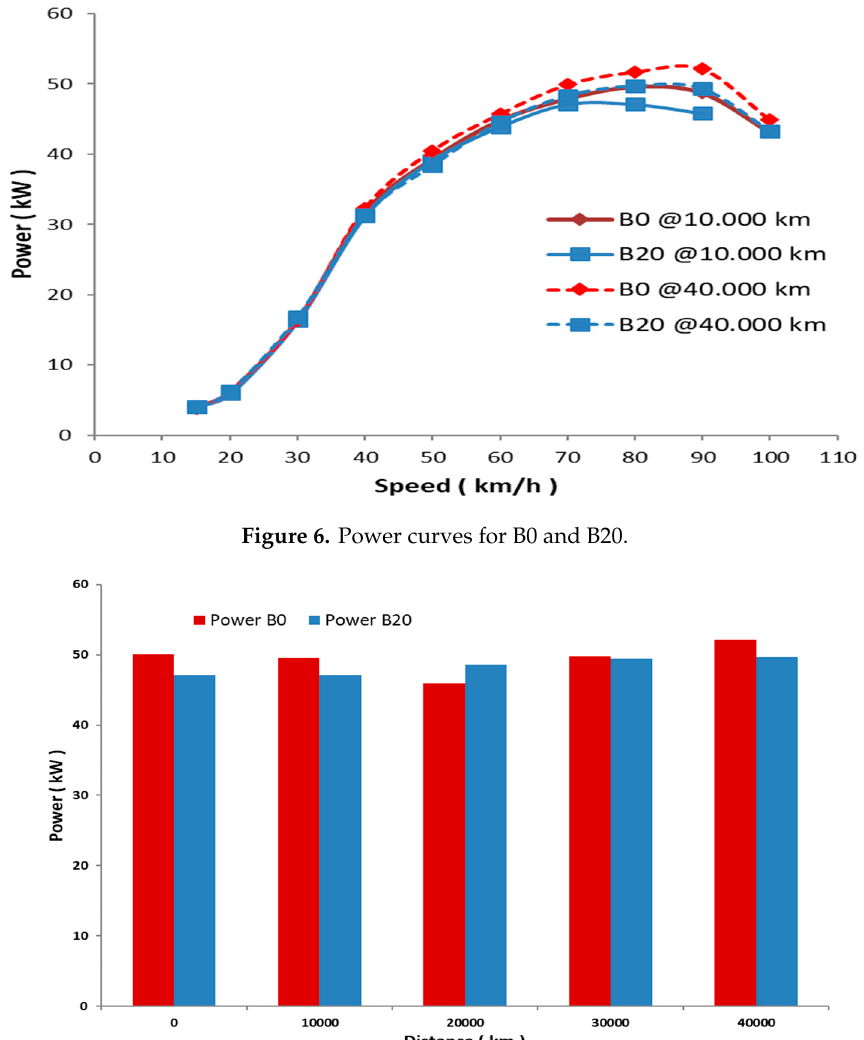
Figure 7. Power maximums for B0 and B20 at each distance traveled.